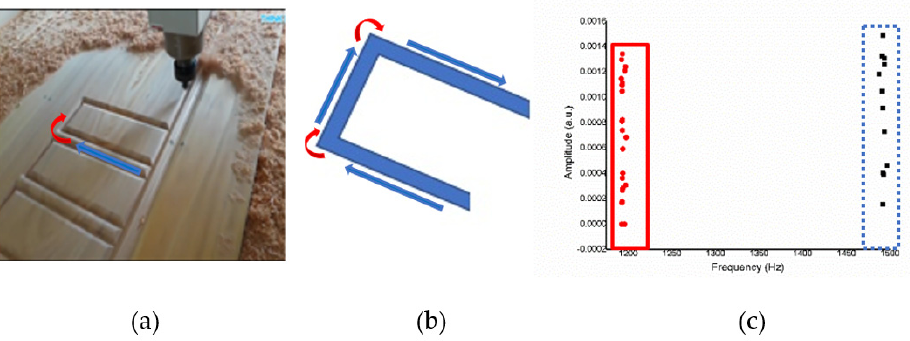
Figure 15. ( a ) Operation sketch, ( b ) trajectory of tool, ( c ) frequency of milling process for wood material.